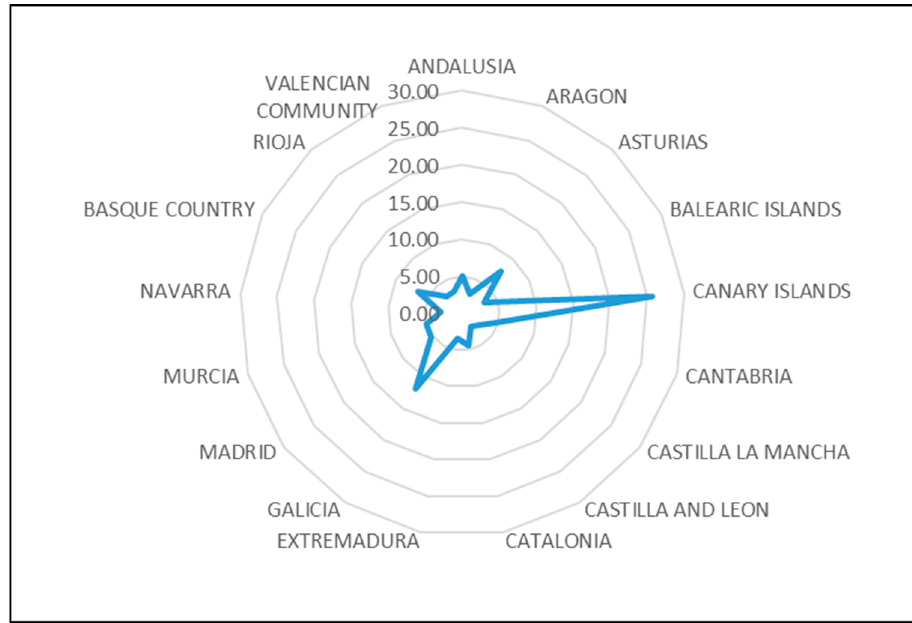
Figure 1. Distribution of funds per hectare in Spain (Source: Own elaboration from data published by the Ministry of Agriculture, Fisheries, and Food).